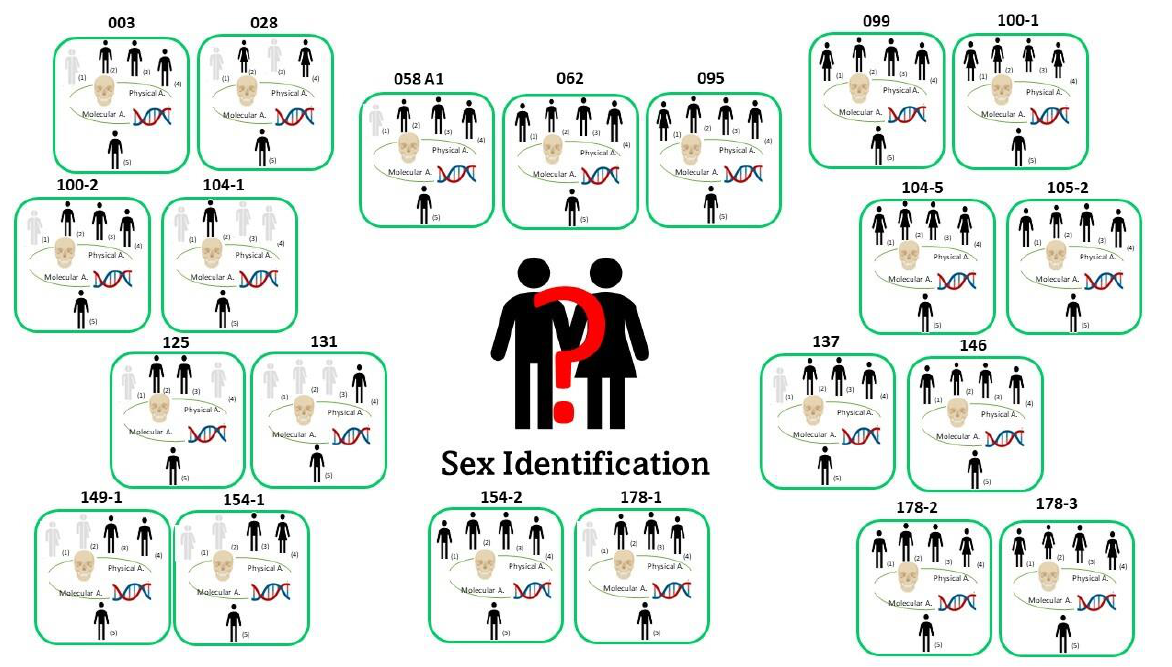
Figure 4. Physical and molecular sex estimation results: ( 1 ) South African White [11]; ( 2 ) South African Black [11]; ( 3 ) Walker [7]; ( 4 ) craniometrics; ( 5 ) molecular method [37]. , male/female and female/male; , male; , female.